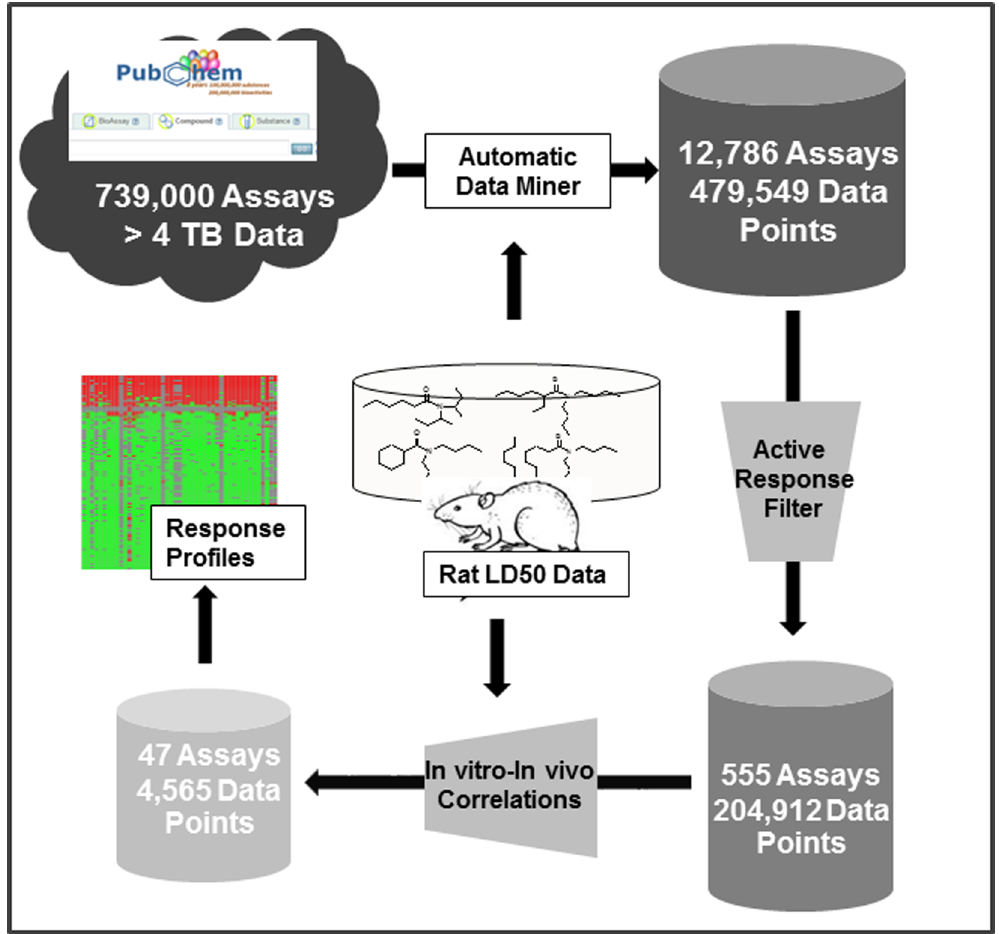
Figure 1. The automatic response profiling based on invitro-invivo relationship.